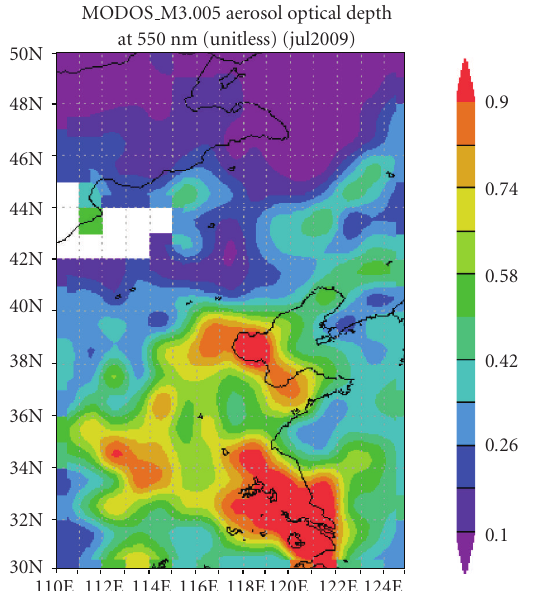
Figure 3: Monthly aerosol optical thickness for August 2008. Observation is from MODIS Terra daytime pass (10:30 AM) via 0.55 micrometer. The image is plotted via http://gdata1.sci.gsfc. nasa.gov/daac-bin/G3/gui.cgi?instance id = neespi.